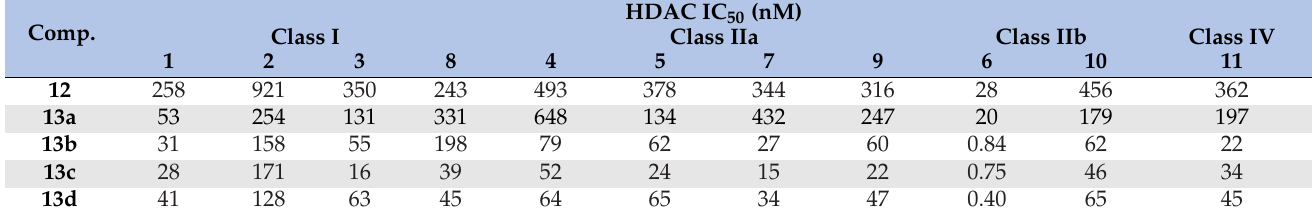
Table 3. In vitro inhibitory activity (IC 50 ) of macrocycles 13a ~ 13d against isoforms HDAC 1–11 [42].